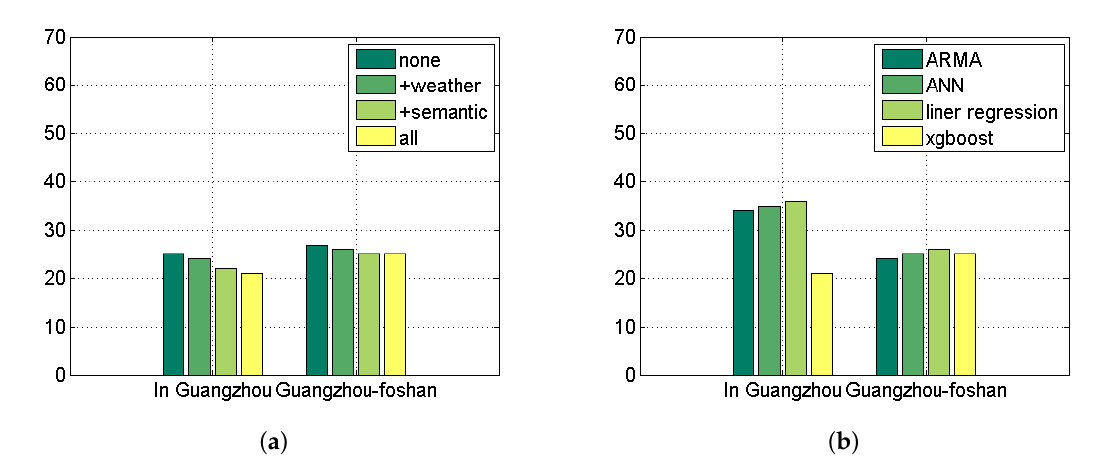
Figure 8. Root mean square error (RMSE) of passenger flow forecasting. ( a ) Features; ( b )